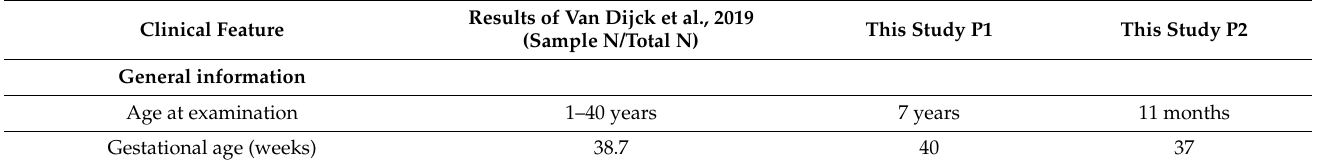
Table 1. Comparison of patients’ symptoms to the results of Van Dijck et al.,